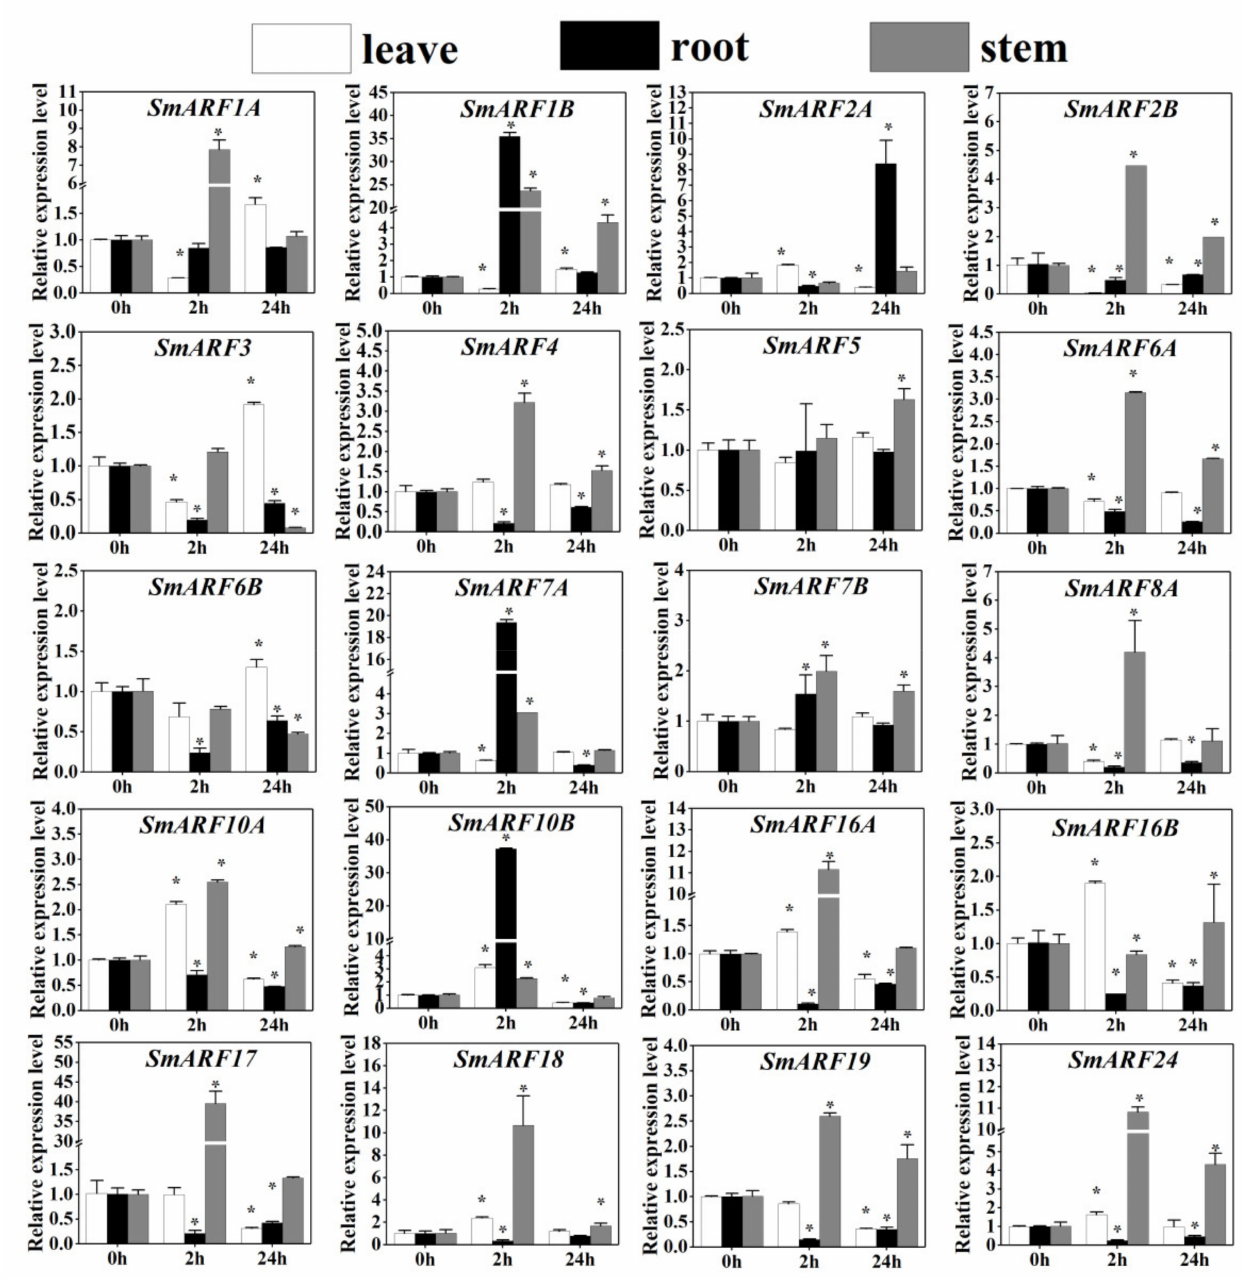
Figure 8. The expression profiles of auxin response factor ( ARF ) genes in eggplant ( Solanum melongena L.) in response to NaCl treatment. The relative expression levels of 20 ARF genes in leaves, roots, and stems of 3 week–old eggplants were measured at 0, 2, and 24 h of treatment. The relative mRNA levels of the group at 0 h were used as for reference. The relative expression was calculated using the method of 2 −(cid:52)(cid:52) Ct . Values are means ± SD ( n = 3). * represents significance at p < 0.05 comparing with the